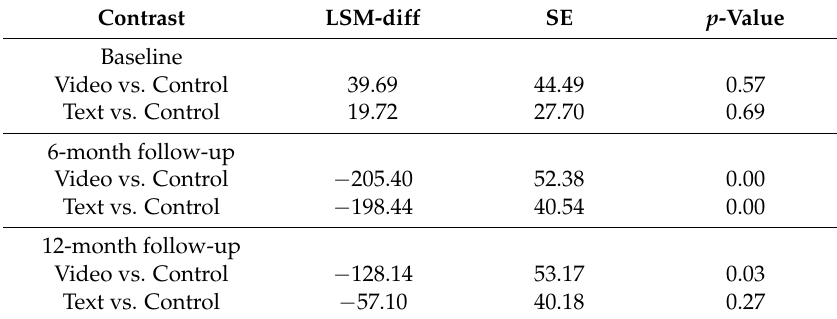
Table 3. Post hoc analysis for study condition and time with energy intake as dependent variable.